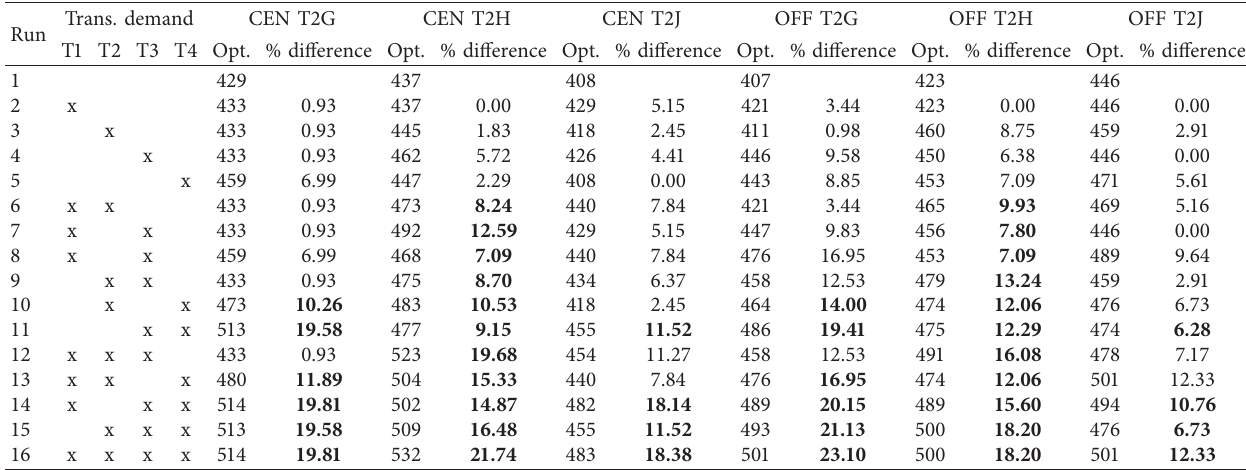
Table 3: Optimal total costs for VRP (Run 1) and VRPT (Runs 2–16) and percentage difference between VRPT and VRP total costs. Trans. demand CEN T2G CEN T2H CEN T2J OFF T2G OFF T2H Run